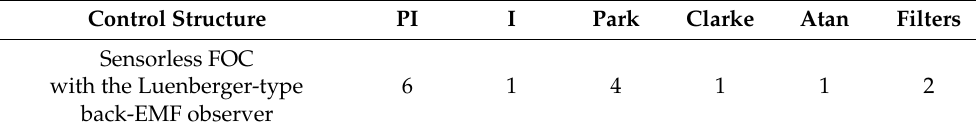
Table 1. Sensorless FOC with the Luenberger ‐ type back ‐ EMF observer—complexity.